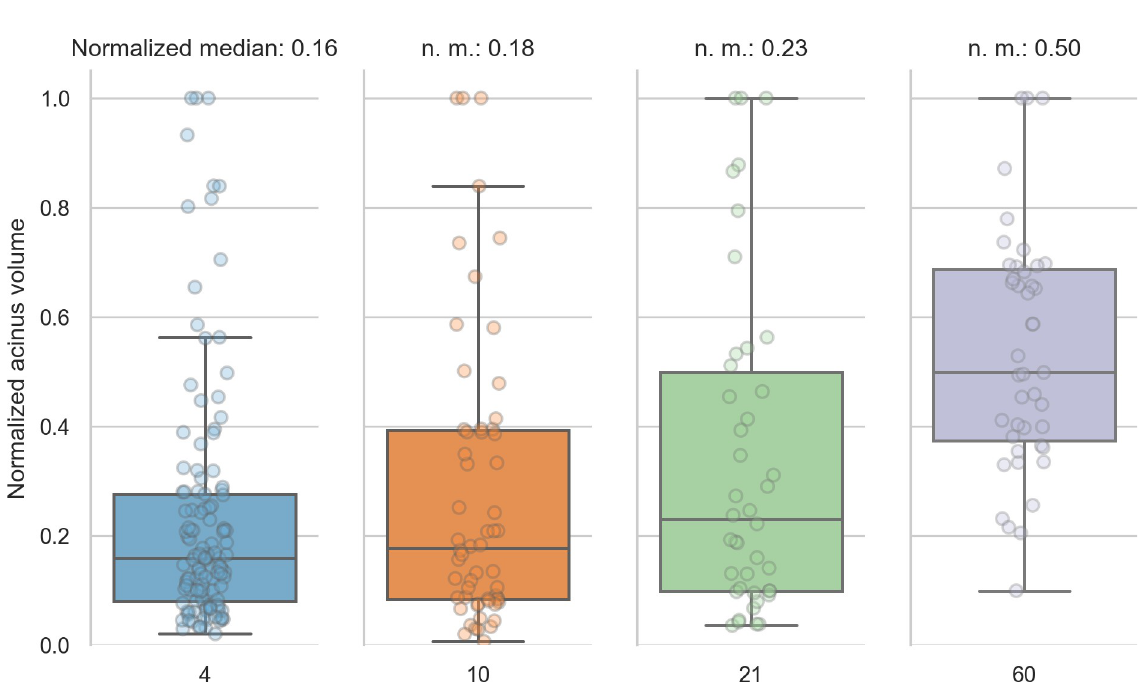
Fig 4. Normalized acinar volumes. The spread of the volumes is small early in the development and skewed towards the lower end of the volumes. At day 60, the median is exactly in the middle of the normalized volumes.